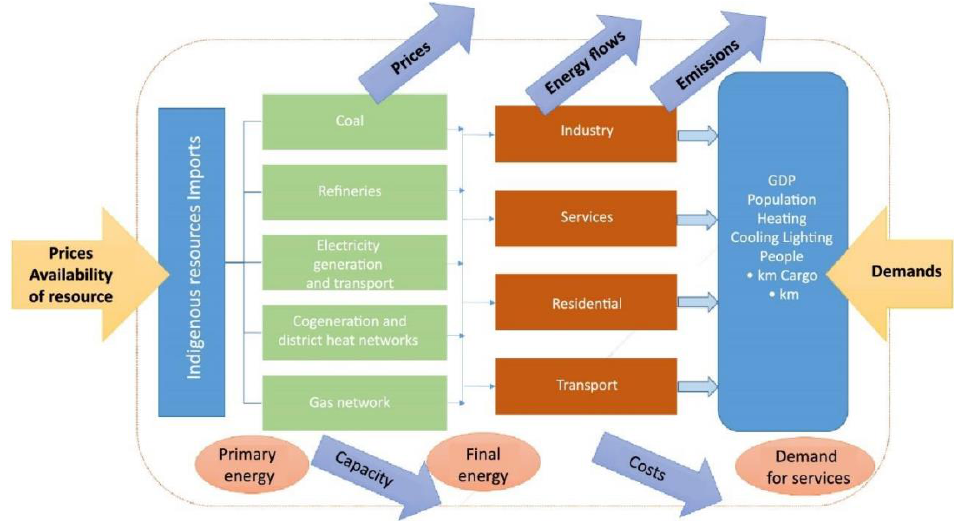
Figure 4. Diagram of TIMES-SINERGIA inputs and outputs (from Figure B.2 in